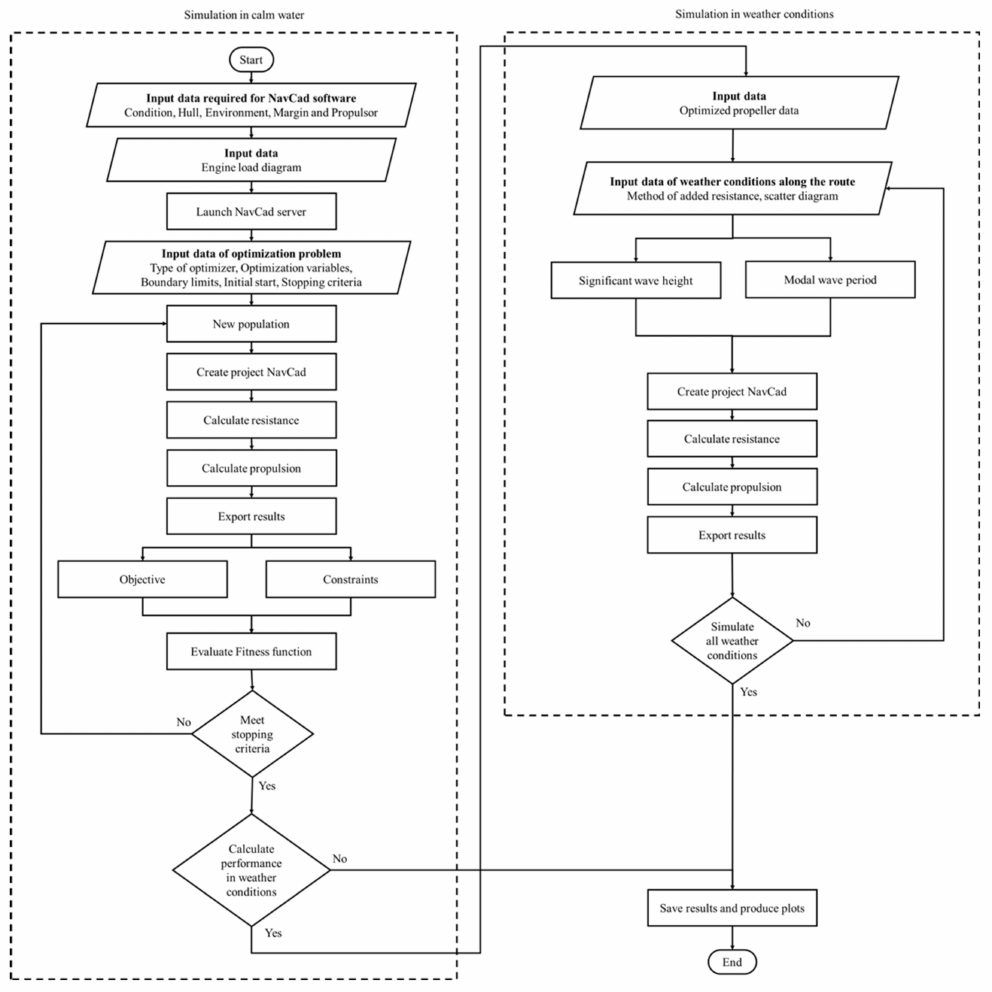
Figure 5. Schematic diagram of optimization tool in calm water and weather